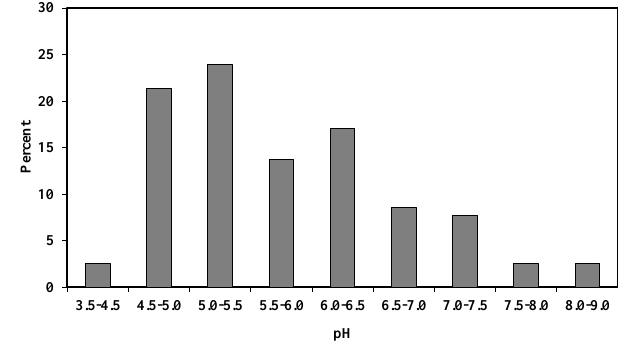
Figure 3. Distribution of pH in rainwater samples collected from